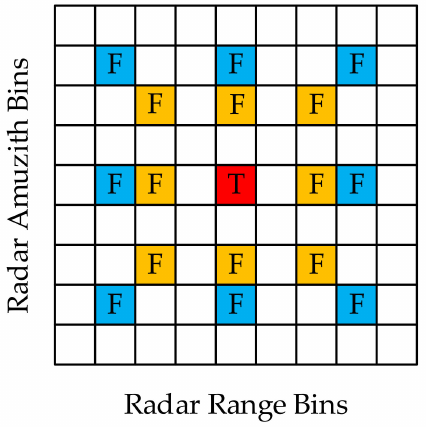
Figure 6. Comparison and decision, where red bin represents the true target, blue bins represent the false targets found with transmission of S 1 ( t ) , and yellow bins represent the false targets found with transmission of S 2 ( t )